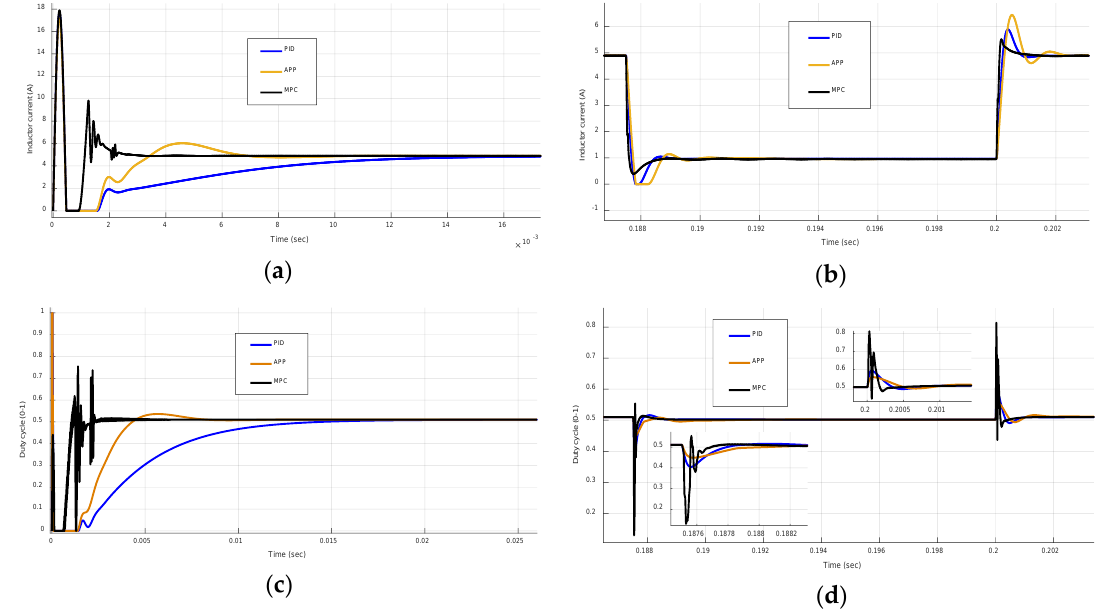
Figure 6. Inductor current and control signal (duty cycle) corresponding to cases Figure 1a,b. ( a ) Inductor current in the startup; ( b ) inductor current for reference input changes; ( c ) control signal in the startup; ( d ) control signal for reference input changes. Zoomed pictures of the waveforms are given above or below, where appropriate, to improve visibility.